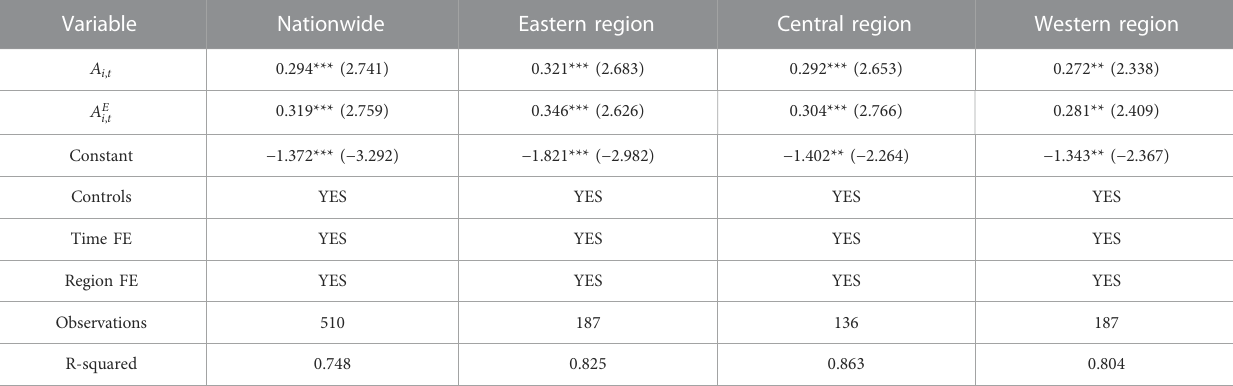
TABLE 5 Regression results of the impact of technical progress on carbon productivity of service industry in China after tail shrinkage treatment.